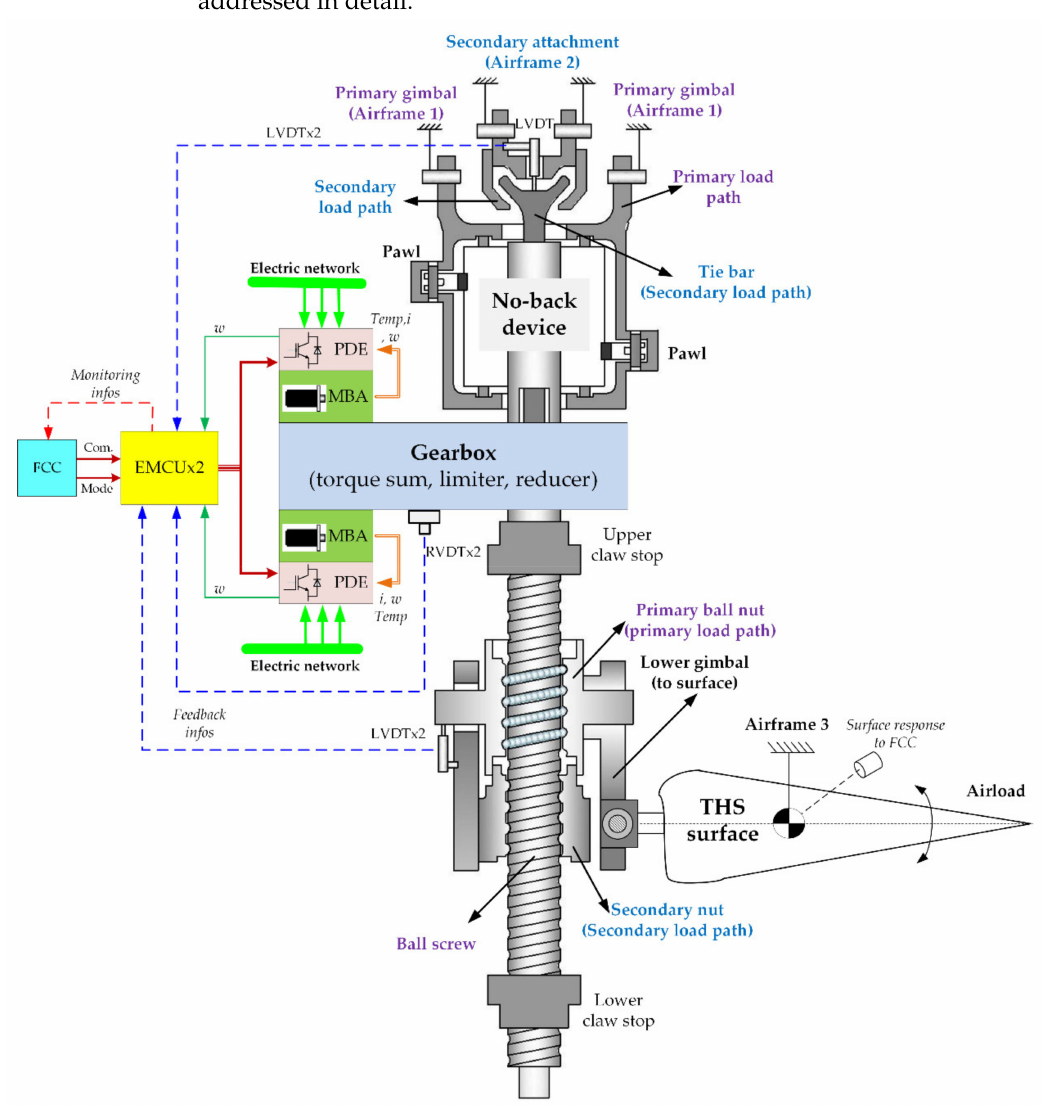
Figure 1. Architecture of THSA